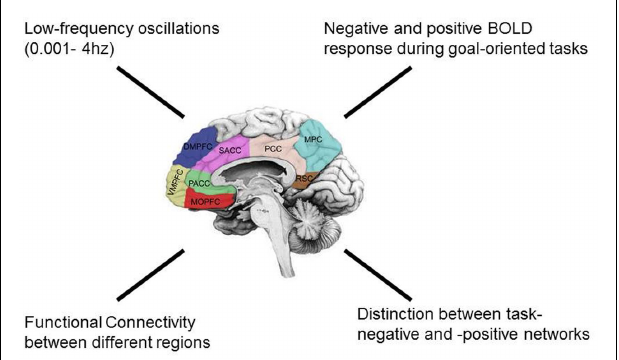
FIGURE 2 | Characteristic features of the brain’s resting state